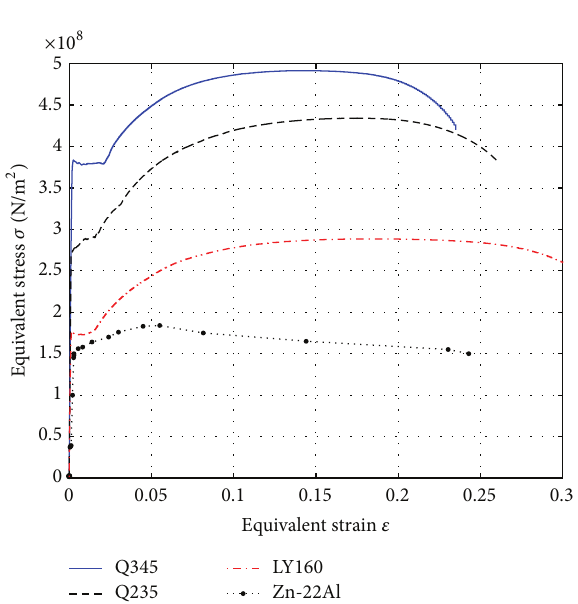
Figure 6: Constitutive curves of different metals.